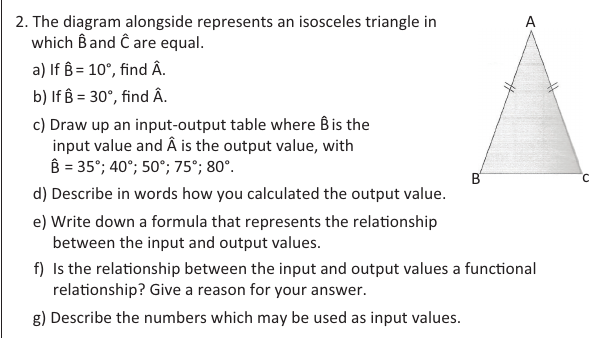
FIGURE 7: Task from Classroom Mathematics Grade 9 on isosceles triangles. 27. Bei gleichschenkligen Dreiecken ergibt sich aus der Grö ß e der Basiswinkel eindeu(cid:10)g die Grö ß e des dri(cid:9)en Winkels. Bes(cid:10)mme die Funk(cid:10)onsgleichung für die Funk(cid:10)on Grö ß e des Basiswinkels → Grö ß e des dri(cid:16)en Winkels. Beachte auch, welche Werte für die Grö ß e eines Basiswinkels möglich sind. Zeichne den Graphen. 27. In isosceles triangles, the size of the base angles clearly determines the size of the third